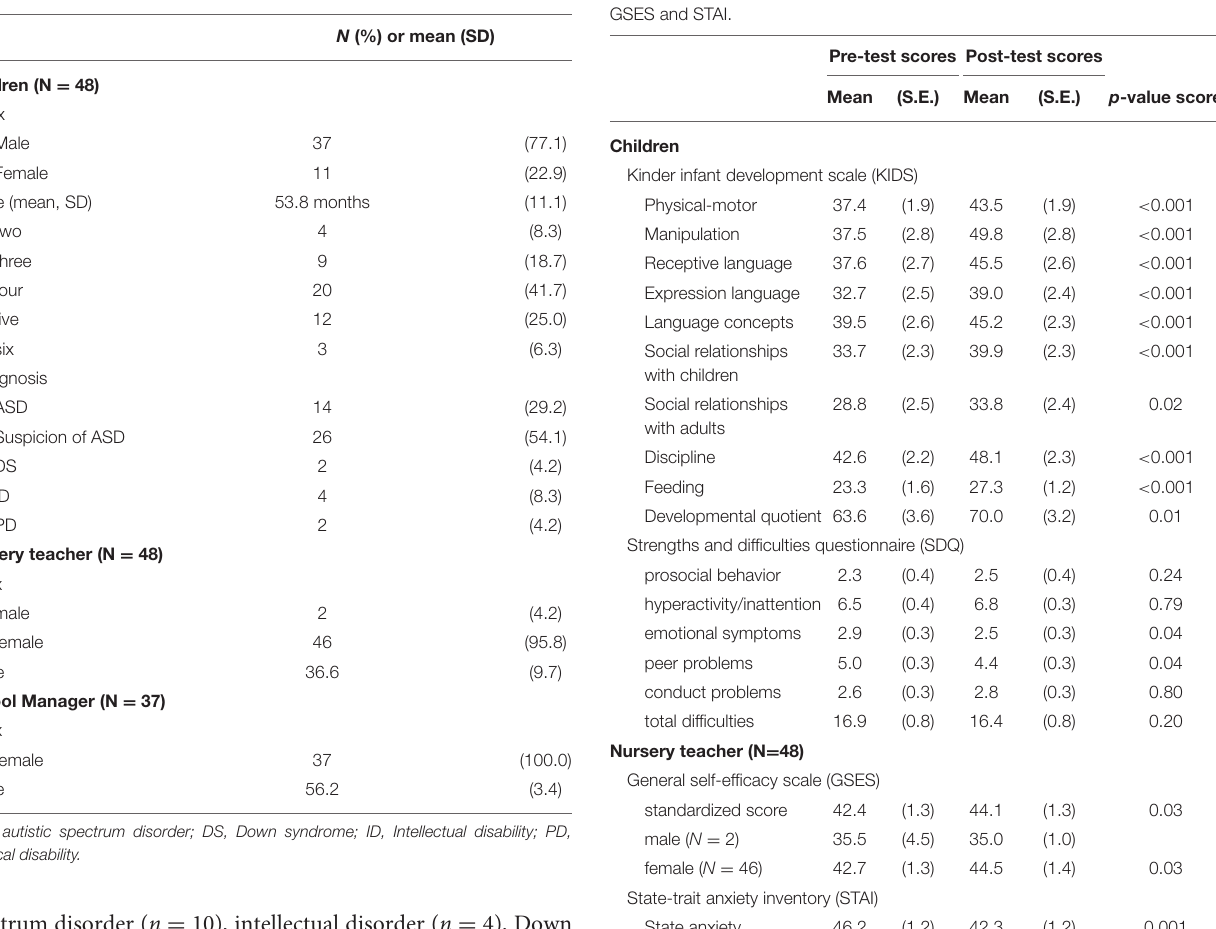
TABLE 1 | Characteristics of children and nursery teachers. TABLE 2 | Pre/post scores of children’s KIDS and SDQ, and nursery teacher’s